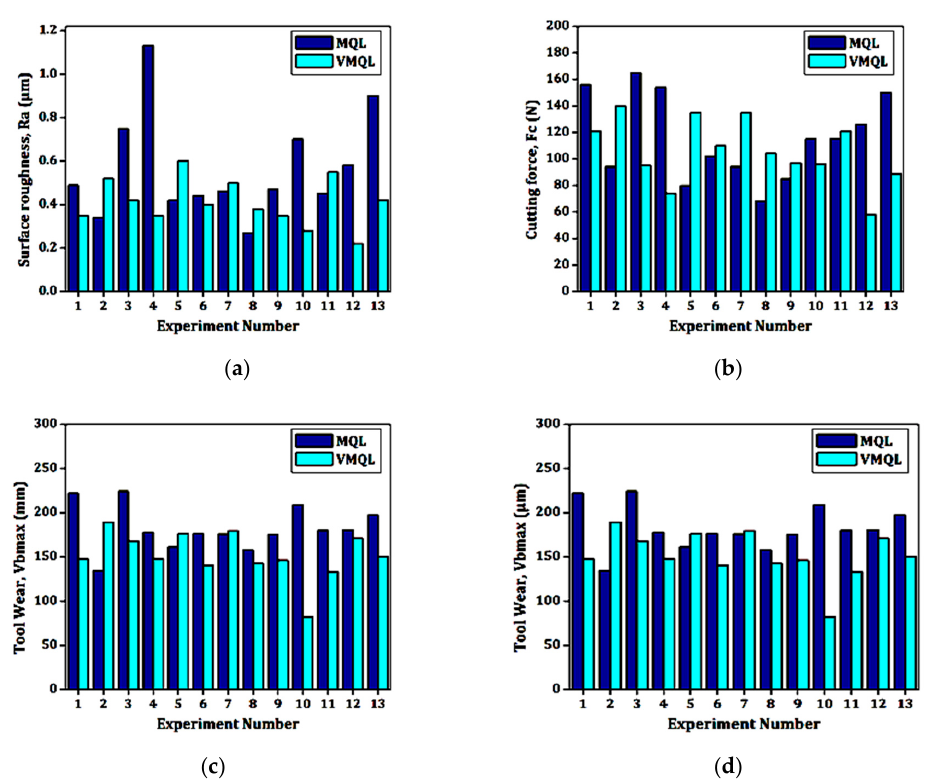
Figure 2. Results ( a ) MQL and vortex tube-assisted MQL(VMQL) comparisons of R a , ( b ) MQL, and VMQL comparisons of F c , ( c ) MQL and VMQL comparisons of VBmax , and ( d ) MQL and VMQL comparisons of cutting power ( P ).